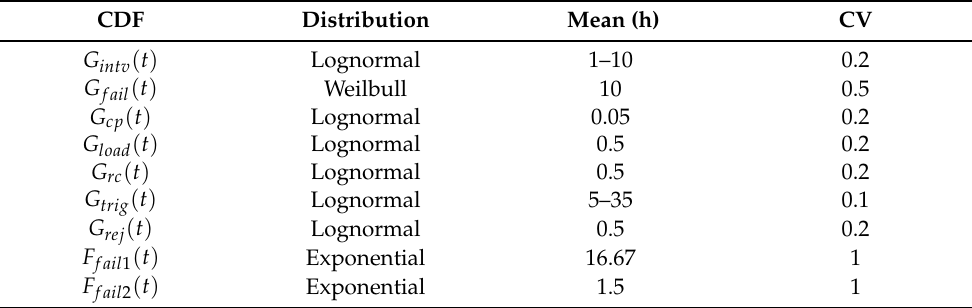
Table 5. Model parameters.